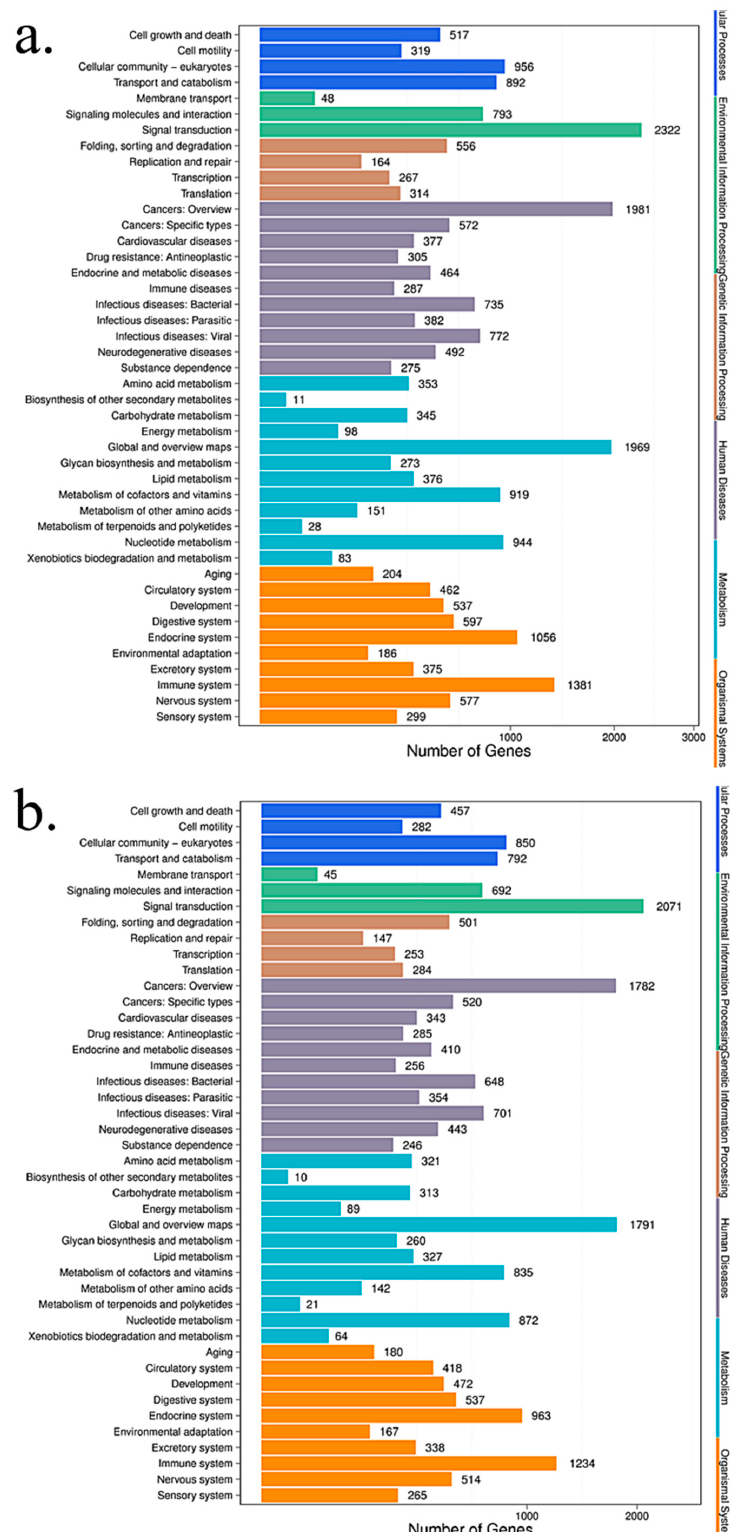
Figure 7. The KEGG pathway annotation classification chart of the differential microRNA target gene. ( a ) 3 μ g/mL group VS control group; ( b) 30 μ g/mL group VS control group. The abscissa is the number of target genes that differ in small RNA, and the ordinate represents the secondary KEGG pathway. The secondary pathways belong to different primary pathways, respectively, and different levels represent the first-level communication categories.